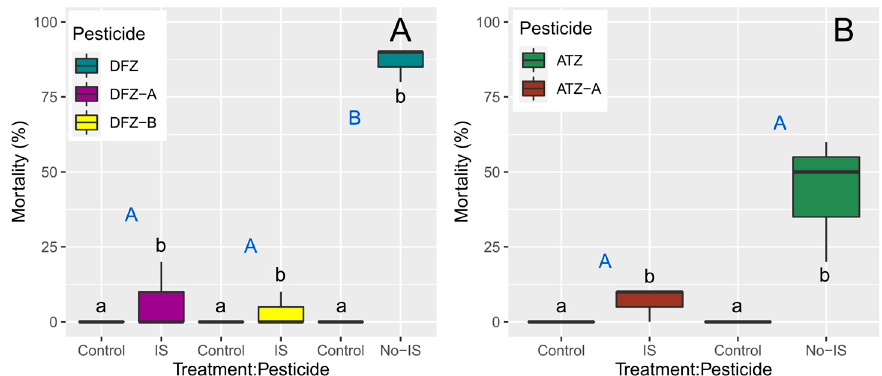
Figure 4. Effects of difenoconazole ( A ) and atrazine ( B ) and their photodegradation products after 48 h of exposure on the percentage of mortality of D. magna . Control refers to a concentration of 0 mg/L, whereas IS (irradiated solution) refers to highest concentration used in the bioassays, i.e., 1.6 mg/L for difenoconazole and its photodegradation products, and 80 mg/L for atrazine and its photodegradation product. Different letters denote significant differences in the means at p ≤ 0.05 (pairwise comparisons) between different treatment (blue uppercase letters) and pesticide concentrations (lowercase letters).